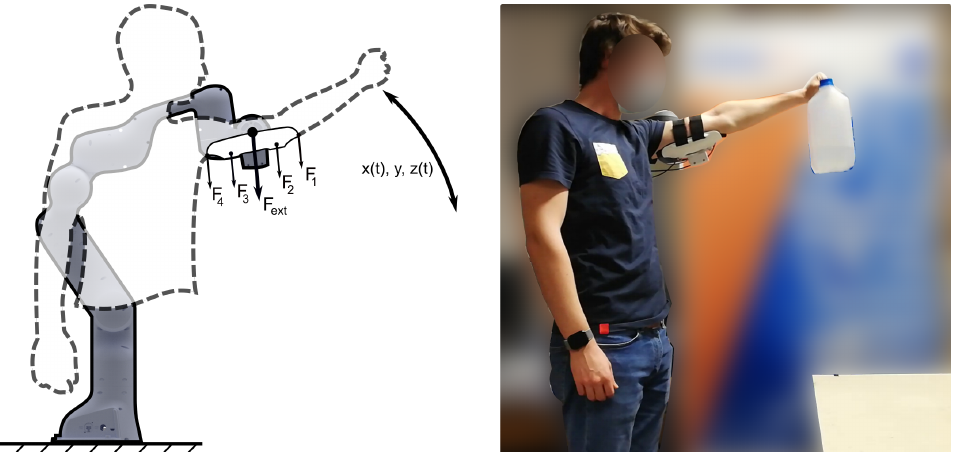
Figure 6. An experiment is designed to calibrate the sensors while the participants are wearing the sensorized interface. Participants are asked to lift a jerrycan up and down, at a self selected speed. The pressure readings are compared to the external forces acting on the end-effector to calibrate the sensors. F 1 , F 2 , F 3 and F 4 are the forces measured by the four sensors, F ext is the force measured at the end-effector, x(t), y and z(t) are the spatial coordinates of the end-effector. The motion of the robot is constrained to the xz-plane, such that y remains